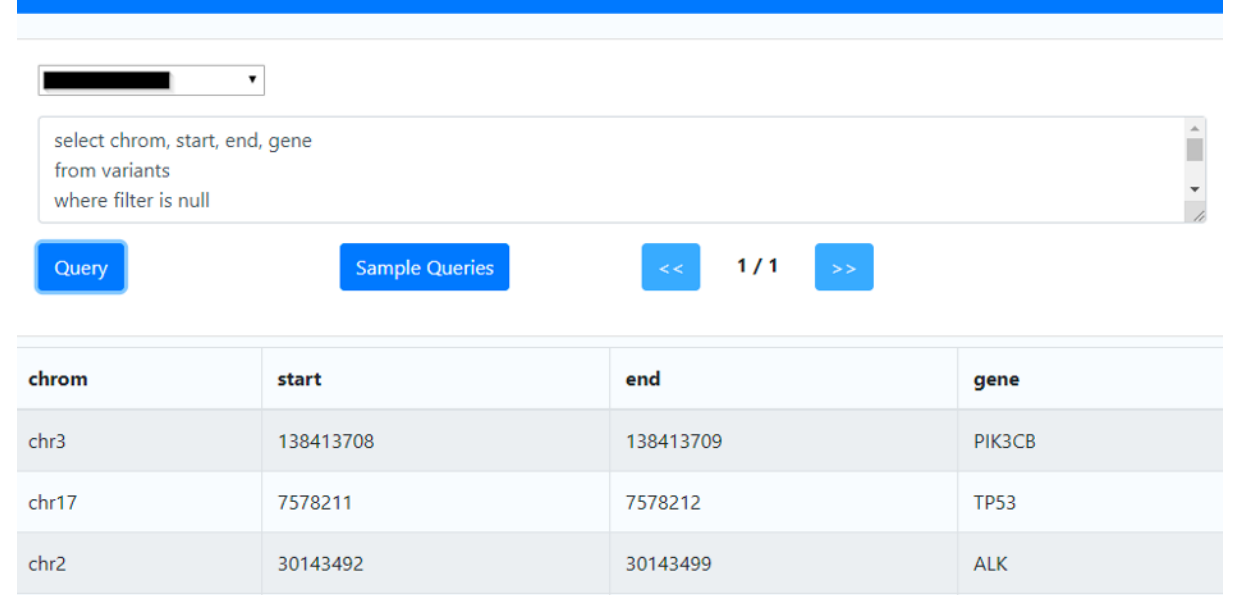
Figure 4. Exemplified user interface.